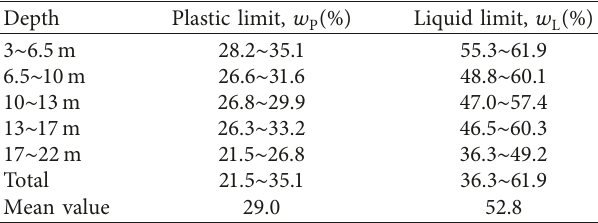
Figure 3: Soil grain size distribution of the granite residual soil. Table 1: The Atterberg limit test result of granite residual soil.